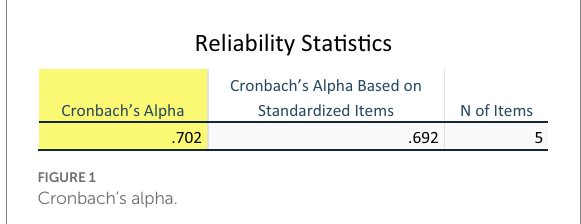
FIGURE 1 Cronbach’s alpha.